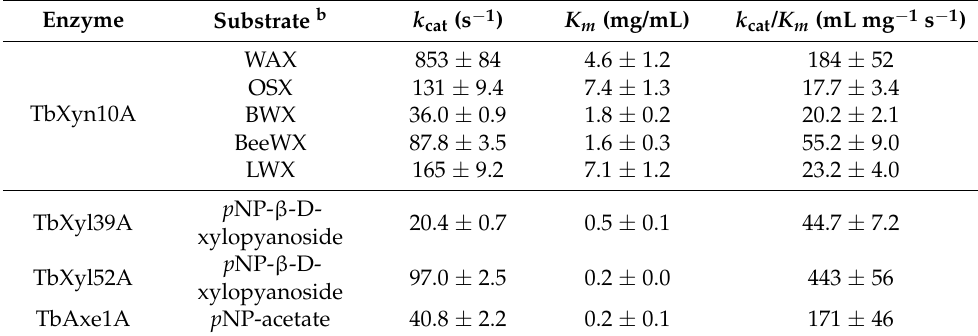
Table 1. Kinetics parameters of TbXyn10A, TbXyl52A, TbXyl39A, and TbAxe1 a .